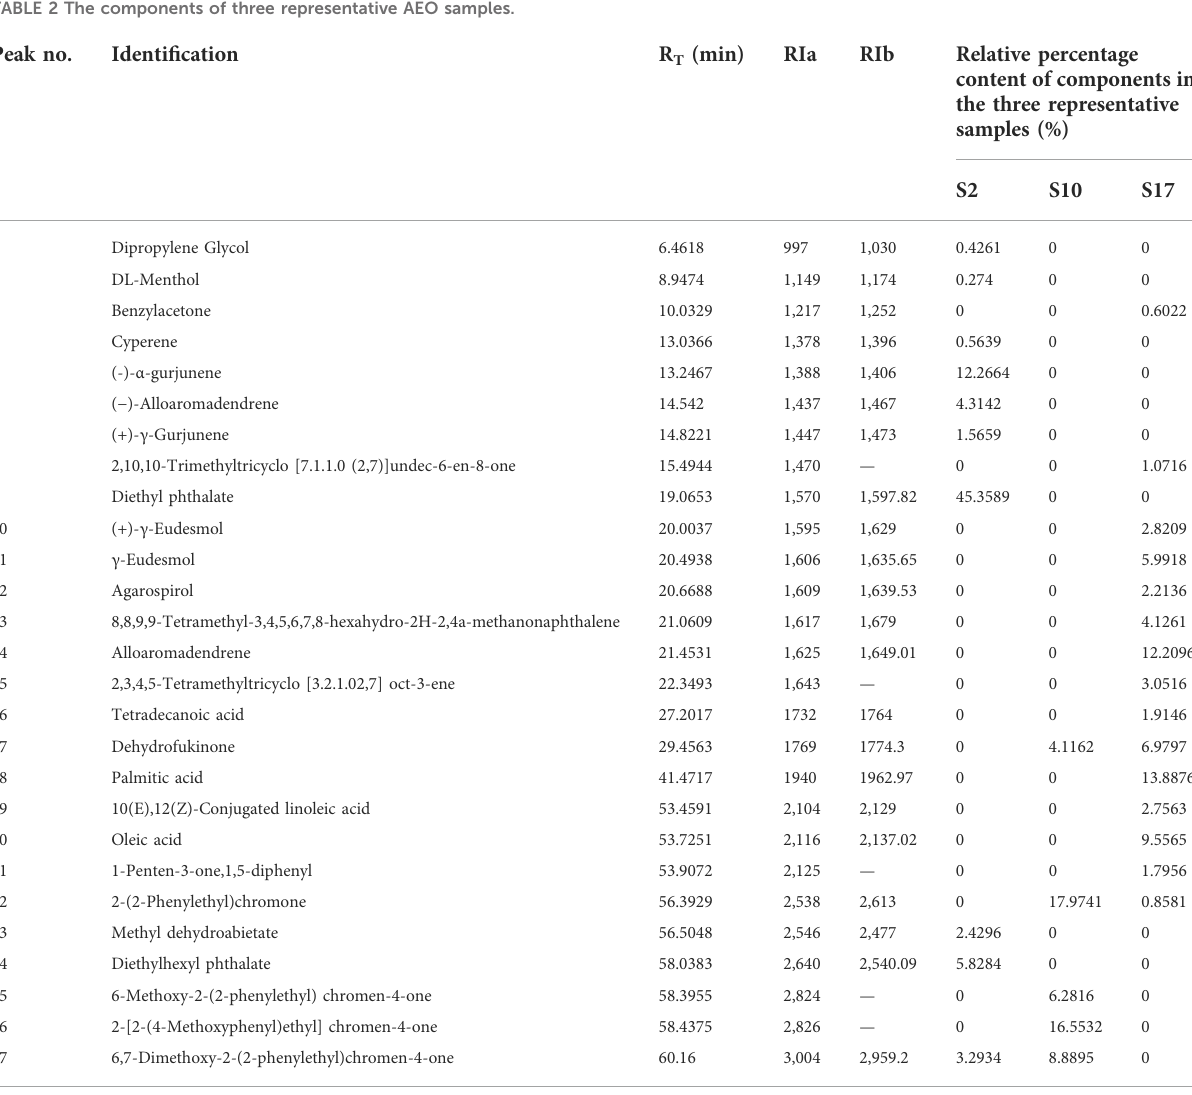
TABLE 2 The components of three representative AEO samples. Peak